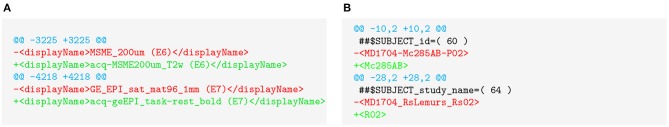
Editing operations on only up to four lines are required to render preexisting data compatible with repositing via the workflow at hand. Depicted are file differences for the 20171024_165248_MD1704_Mc285AB_P02_1_1 testing dataset scan, in a patch syntax. The line numbers identifying the position of the text segment (before and after editing) are highlighted between arobase characters and in cyan. Deleted and added lines are highlighted in red or green, and prefixed with a minus or plus, respectively. Conserved lines are printed in black. (A) A total of two lines need to be edited in the ScanProgram.scanProgram file in order to render acquisition, task, and contrast automatically interpretable. (B) A total of two lines need to be edited in the subject file in order to make session and subject information automatically interpretable.